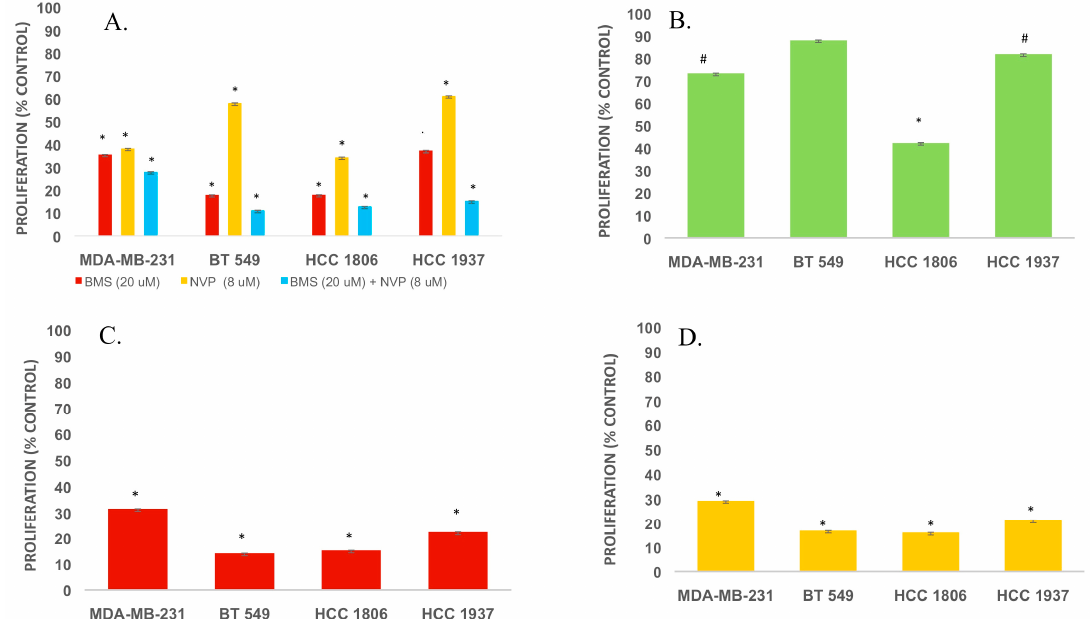
Figure 6. ( A – D ) Effects of dual therapy with IGF1R/IR and AR antagonists on TNBC proliferation. TNBC cells were grown in 96-well plates to 50–60% confluence in complete media. ( A ) Cells were maintained in phenol red-free RMPI 1640 media supplemented with 2% cFBS and either NVP-AEW541 (8 µ M, IGF1R inhibitor; Selleckchem) or BMS-754807 (20 µ M, IGF1R/InsR inhibitor; Selleckchem), alone or in combination; ( B ) Cells were exposed to media containing enzalutamide (20 µ M, AR inhibitor; Selleckchem) and proliferation was assessed after 72 h; ( C ) Cells were cultured in media containing BMS-754807 and enzalutamide for 72 h or ( D ) in media containing NVP-AEW754 and enzalutamide for 72 h. Thereafter, cell proliferation was measured using the Celltiter 96 ® Aqueous Proliferation Assay (Promega, Madison, WI, USA). # p -value < 0.05, * p -value < 0.001. SD: standard deviation ( n = 3).